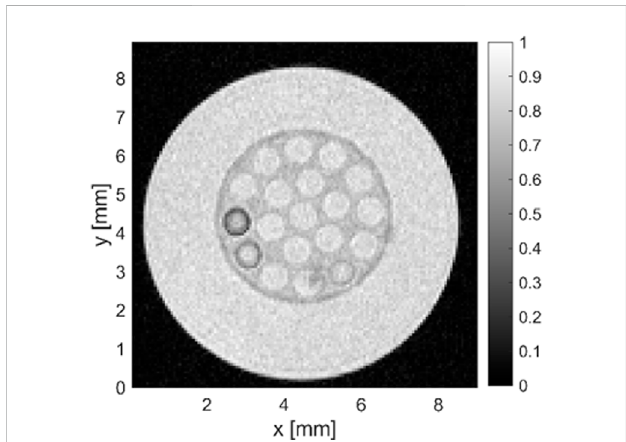
MR image after backwashing of the membrane: in four channels, the deposit is still observed to different extents, one being blocked (left), the neighboring channel still covered, but fl uf fi ly. A detached piece of the alginate gel is visible in the channel on the bottom, while its neighbor shows a less dense and loose